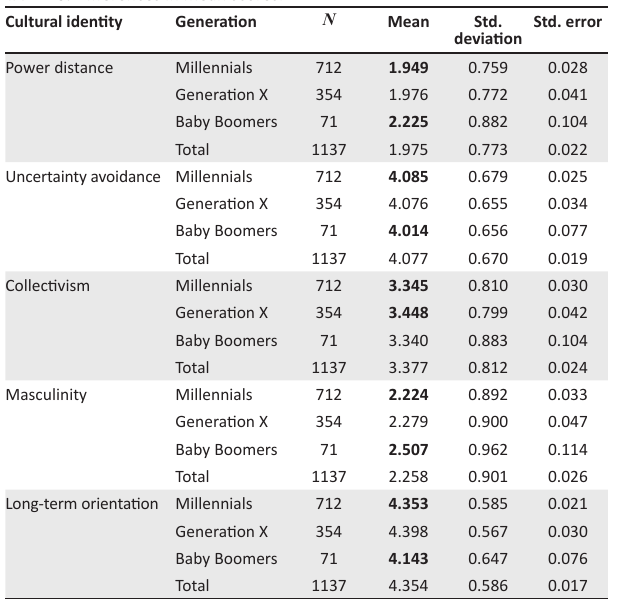
TABLE 6: Differences in mean scores. Cultural identity